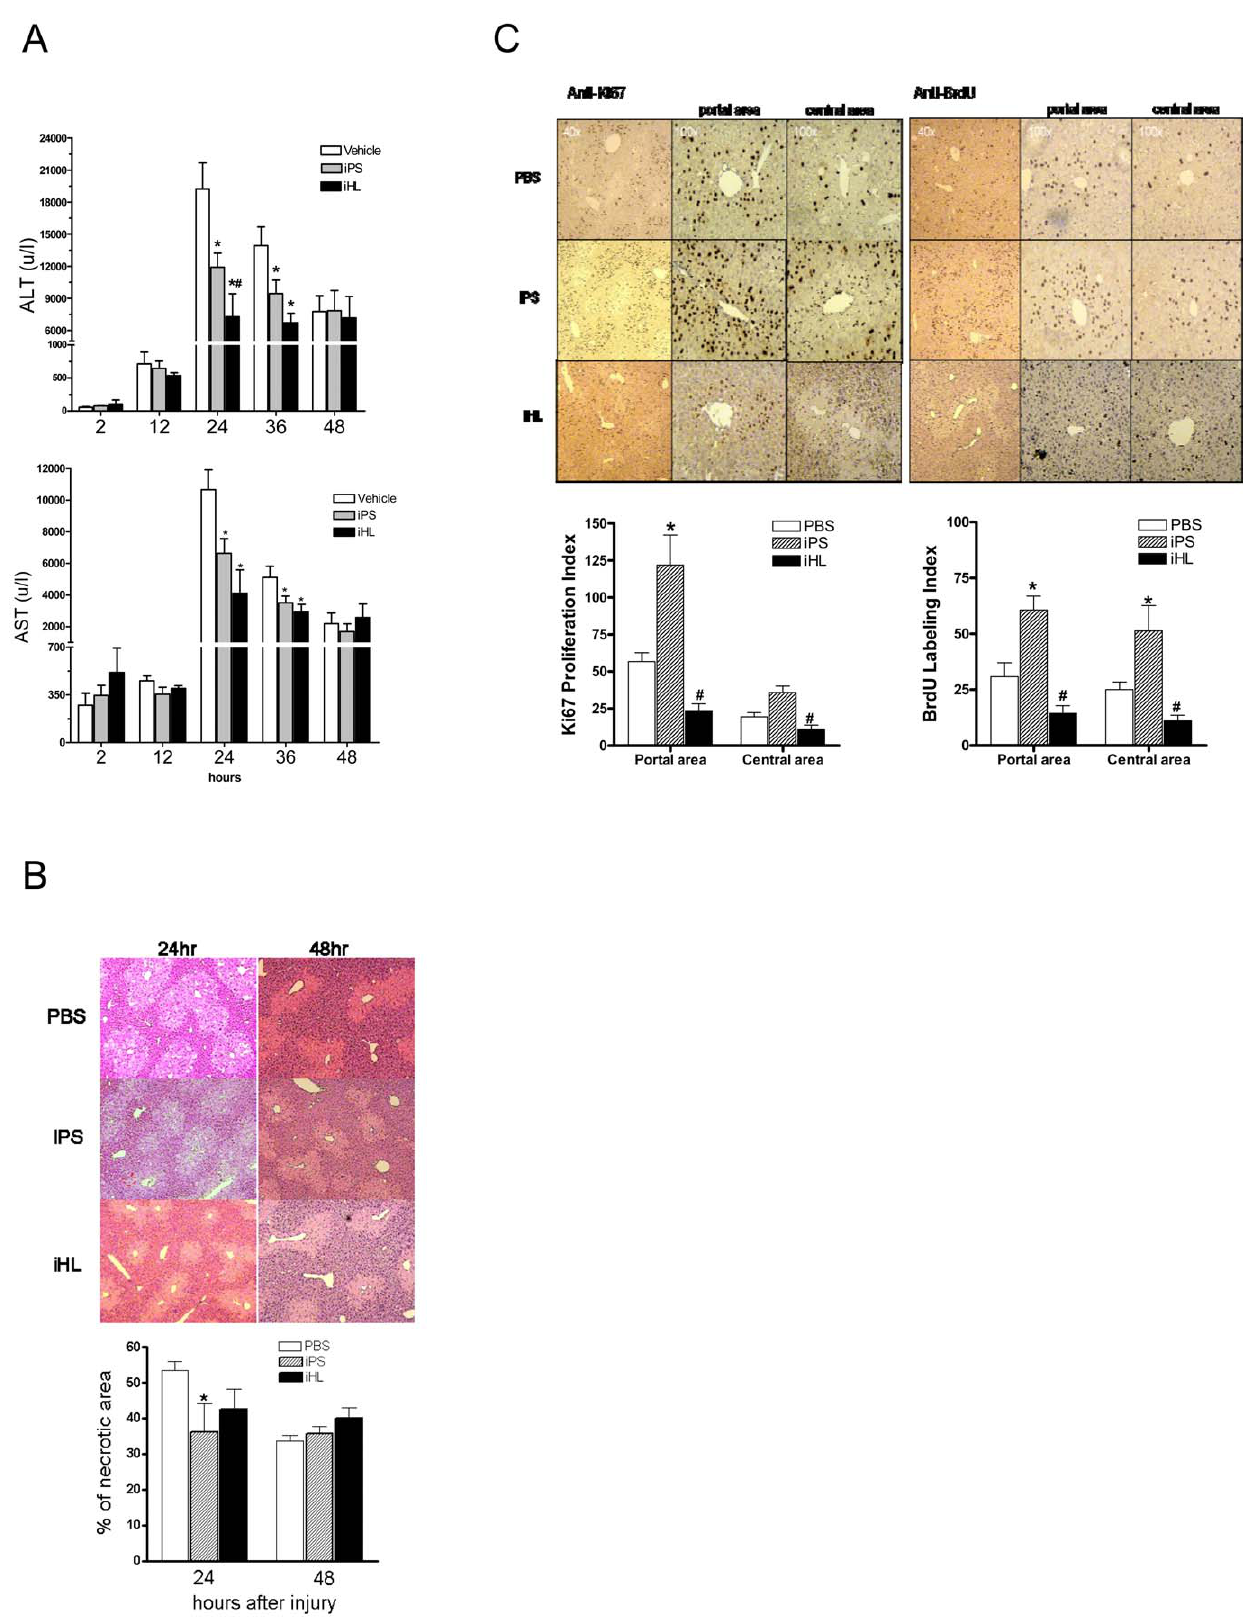
Figure 1. iPS and hepatocytes transplantation reduced hepatic injury. ( A ) Mean AST and ALT levels in mice receiving PBS (open bars), iPS (gray bars), and iHL (solid bars) following CCl 4 treatment (n=6, *P , 0.05 vs. PBS, # P , 0.05 vs. iPS). ( B ) Representative liver sections from CCl 4 -injured